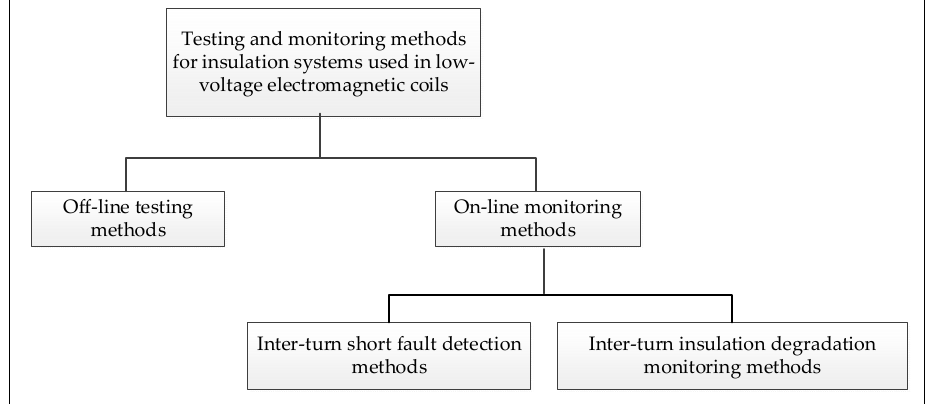
Figure 1. Categories for testing and monitoring methods for insulation systems used in low-voltage electromagnetic coils.